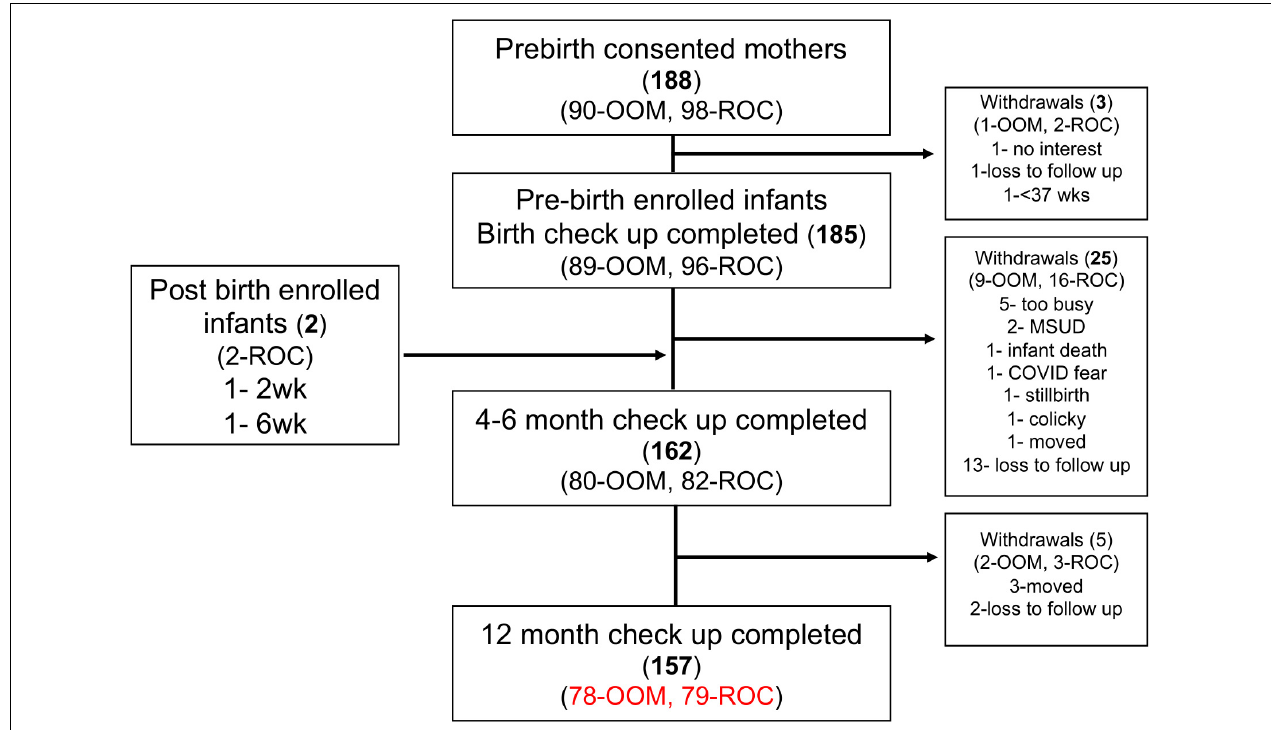
FIGURE 2 | Old Order Mennonite (OOM) and Rochester (ROC) cohort recruitment through the first year of life. Follow up with the infants will continue at 18 and 24 months, as well at 3, 4, and 5 years of age. MSUD, maple syrup urine disease.